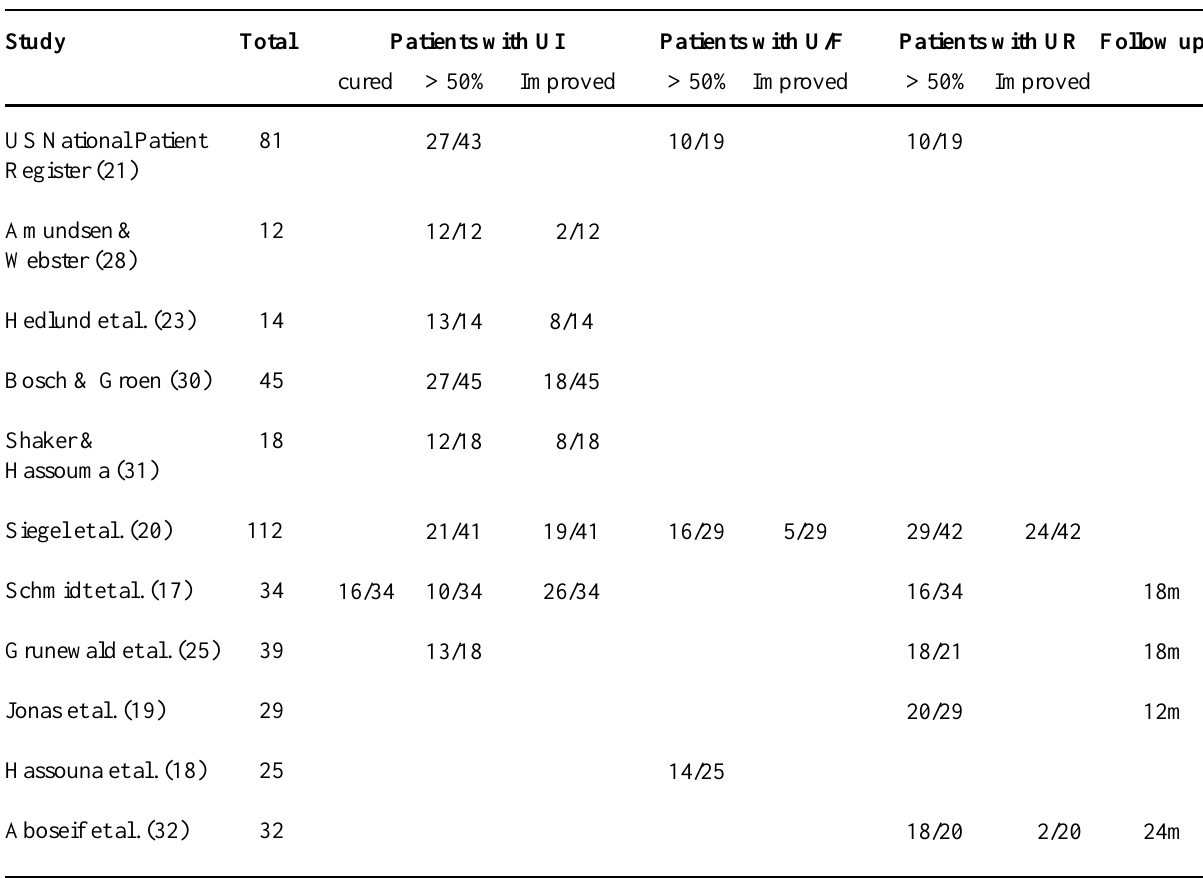
Table 1 – Published reports of use of SNS in various conditions of lower urinary tract dysfunction: urge incontinence